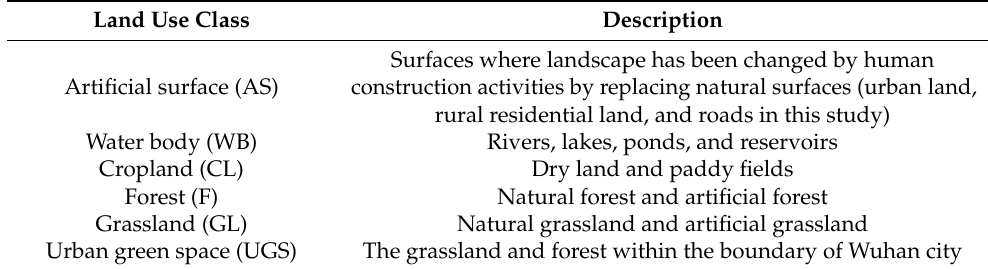
Table 1. Land use classification of Wuhan urban